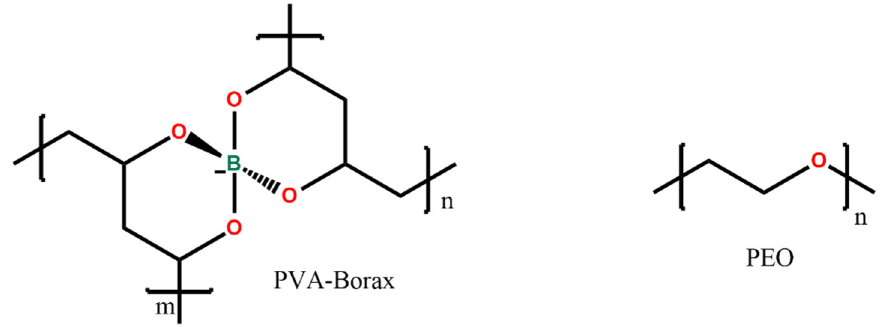
Figure 8. Chemical structure of the hydrogel compounds.